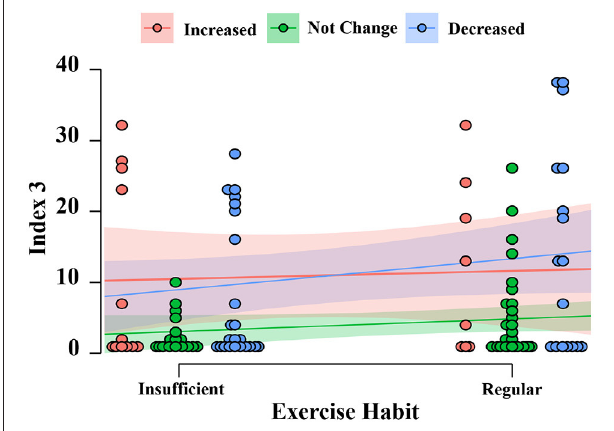
FIGURE 9 | Index 3 for young group. Plots are drawn using mean values and 95% confidence